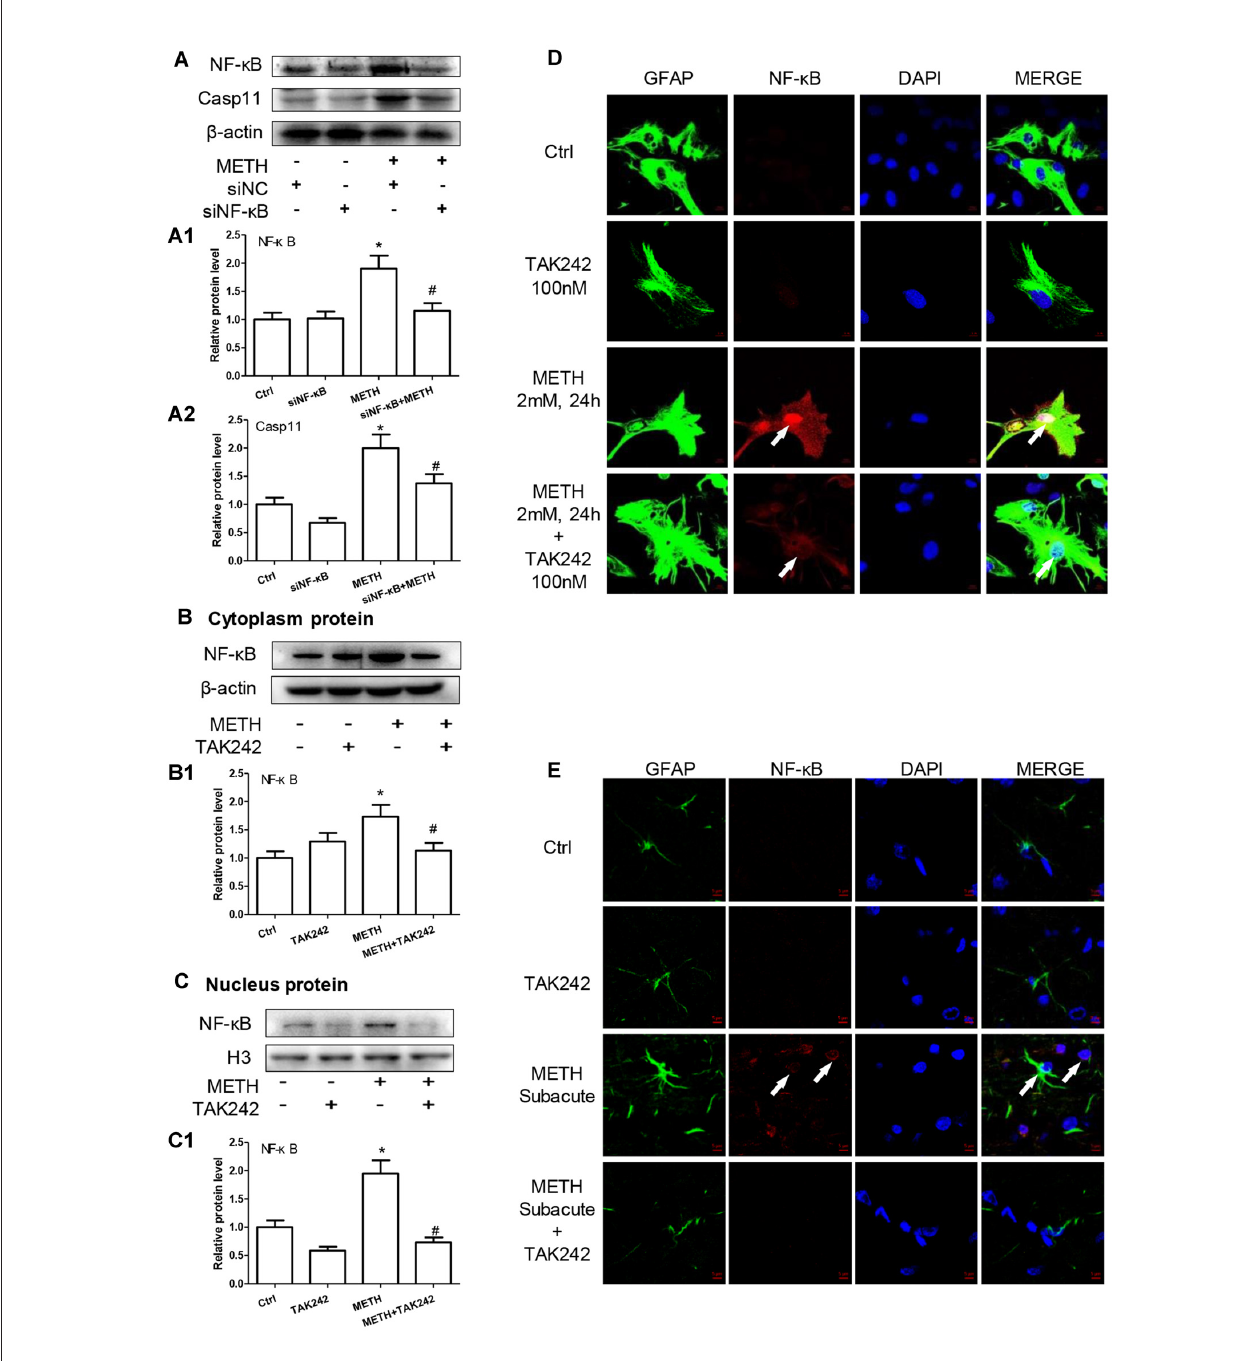
FIGURE 6 | TLR4 induces translocation of NF- κ B into the nucleus, leading to an increase of Caspase-11 transcription in METH-exposed astrocytes. (A–A2) Primary cultured astrocytes were transfected with siRNAs targeting NF- κ B or control siRNA for 24 h followed by METH (2 mM) treatment for 24 h. (B–D) Cells were exposed to TAK-242 (100 nM) for 2 h prior to METH (2 mM) treatment as indicated, nucleus proteins (C,C1) and cytoplasm (B,B1) proteins were extracted separately. Western blot (A–C) and quantitative analyses were performed to determine NF- κ B, and Caspase-11 protein expression. H3 was used as the loading control of nucleus proteins. Immunolabeling and confocal imaging analysis (D) showed elevated NF- κ B expression in the METH-treated cells compared with controls. (E) The animal exposure paradigms were the same as described in Figure 4 . Immunolabeling and confocal imaging analysis showed elevated NF- κ B expression in the midbrain of METH-exposed mice compared with controls. White arrow refers to NF- κ B. Cell experiments were repeated three times. Data are expressed as mean ± SD. ∗ p < 0.05 vs. non-METH-treated group. # p < 0.05 vs. the scrambled + METH treated group. Data were analyzed with 2 × 2 factorial ANOVA followed by LSD post hoc